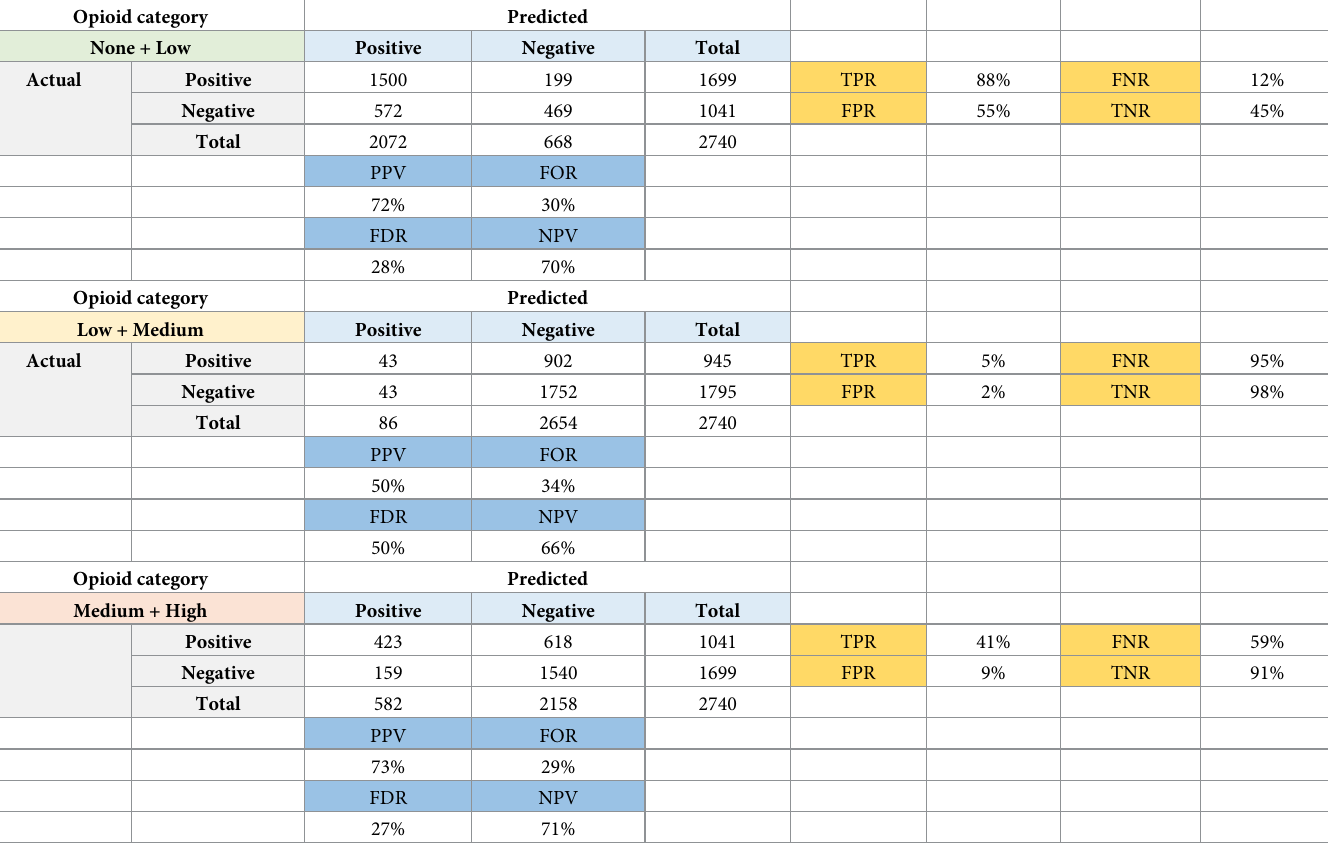
Table 7. Confusion matrix for each category of opioid requirement with true positive, true negative, false positive and false negative counts are shown. Also, pre- sented are the True Positive Rate (TPR), False Negative Rate (FNR), False Positive Rate (FPR) and True Negative Rate (TNR). Positive Predictive Value (PPV), False Omis- sion Rate (FOR), False Discovery Rate (FDR) and Negative Predictive Value (NPV) are also presented. Opioid